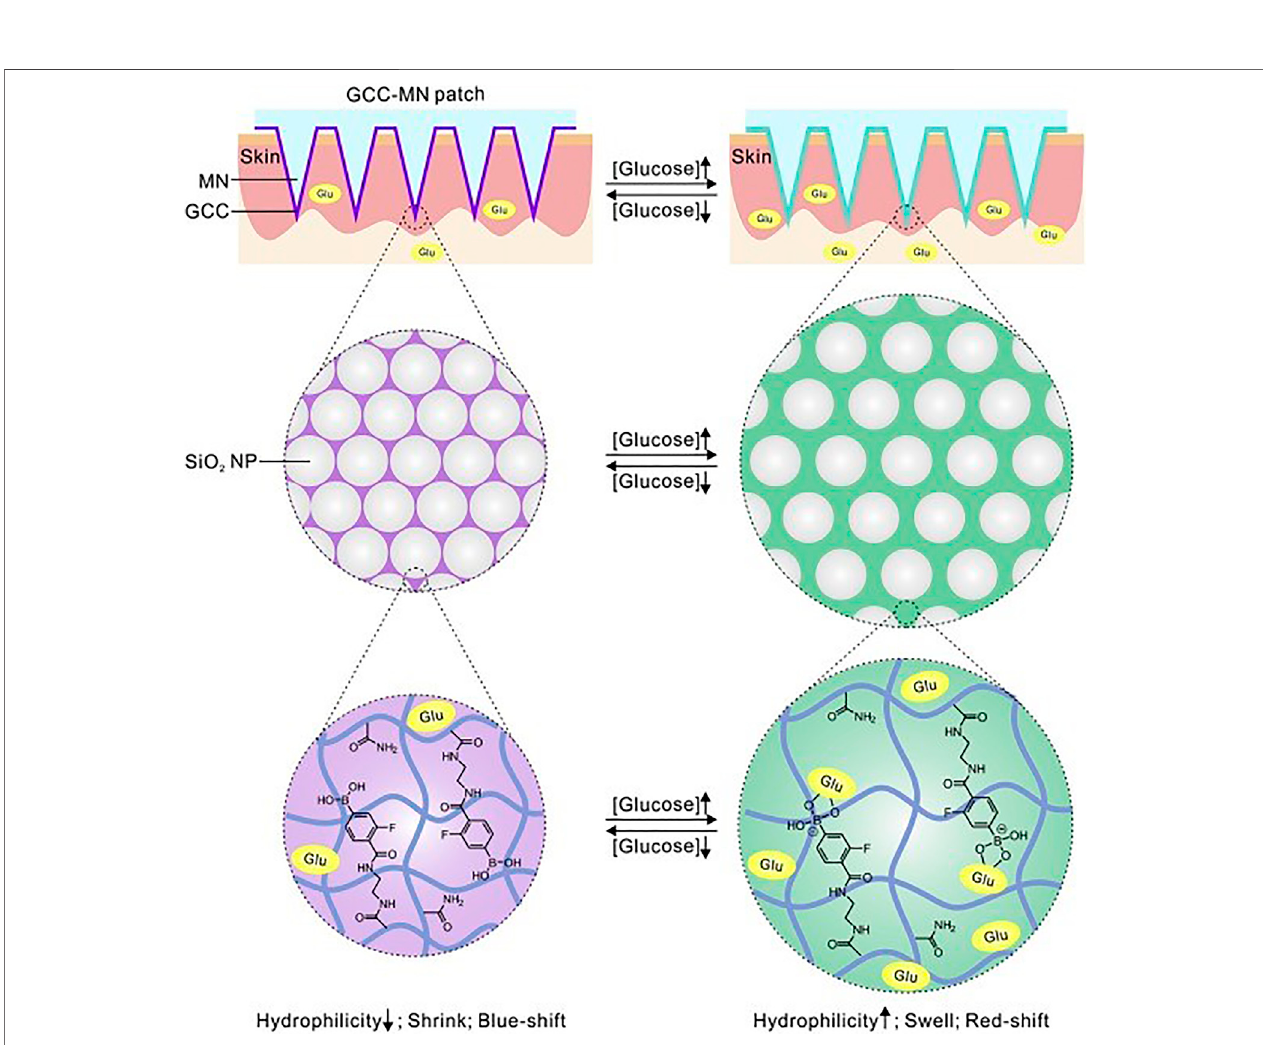
FIGURE6| Schematically illustrated theformulation and mechanism ofthe GCC-MN patchfor naked eyemonitoring ofglucose concentrations. Reproduced with permission (Zeng et al., 2020). Copyright 2020, Elsevier.